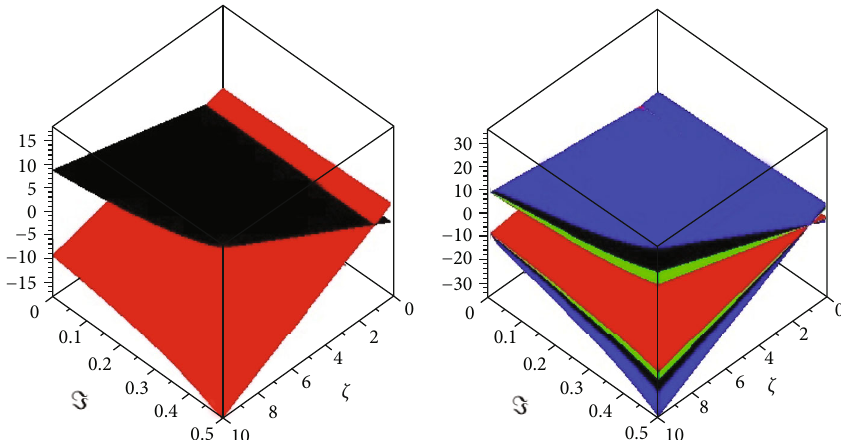
Figure 6: The fi rst graph shows the approximate solution of fuzzy upper and lower portions, and the second fi gure is the various fractional order of ℘ .